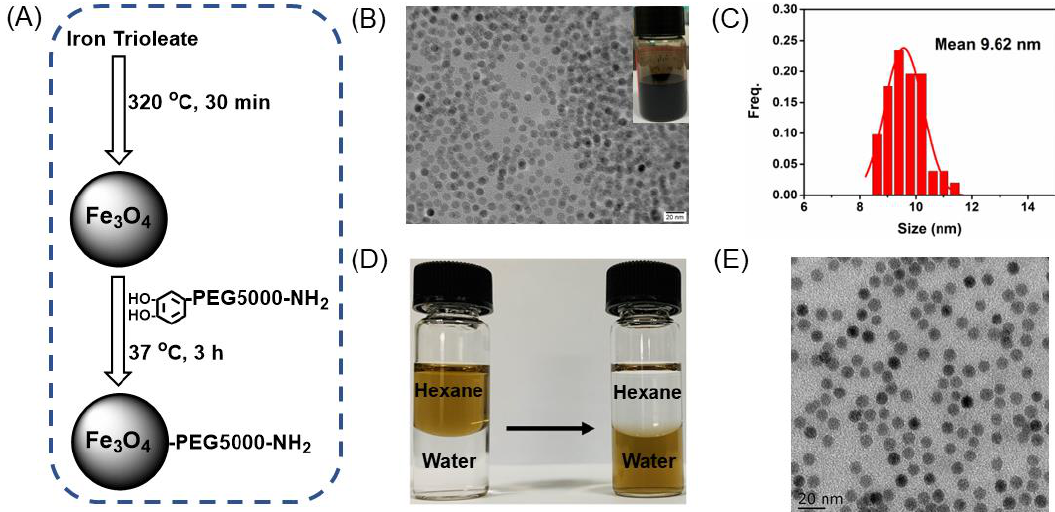
Figure 1. Characterizations of Fe 3 O 4 nanoparticles. ( A ) Schematic description of the synthesis of oleic acid-capped hydrophobic Fe 3 O 4 – OA nanoparticles and catechol – PEG5000 – NH 2 modified hydrophilic Fe 3 O 4 – NH 2 nanoparticles. ( B ) TEM image of Fe 3 O 4 – OA nanoparticles. Inset: photo- graph of the sample Fe 3 O 4 – OA nanoparticles dispersed in hexane. ( C ) The diameter distribution